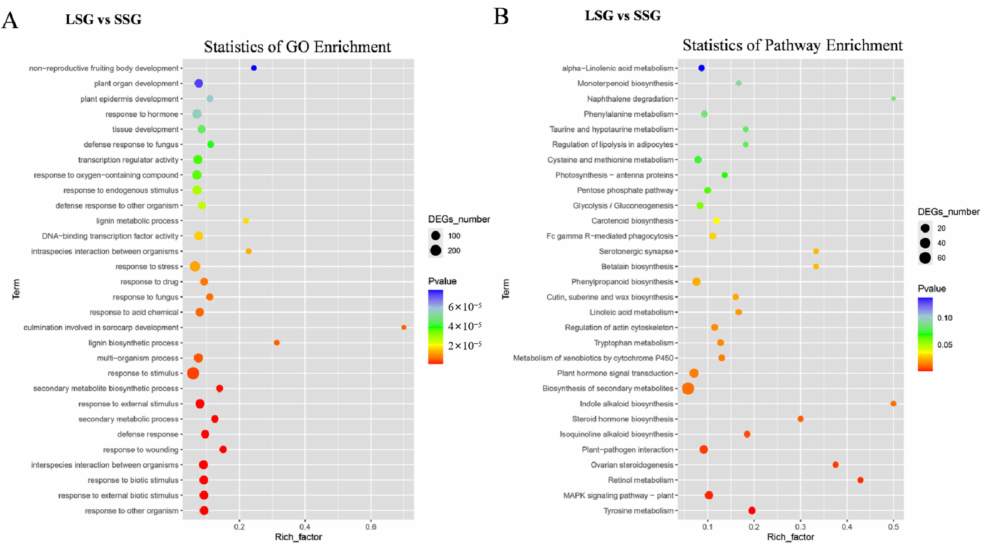
Figure 4. GO and KEGG enrichment analysis of DEGs between LSG and SSG. ( A ) GO enrichment analysis of DEGs; ( B ) KEGG enrichment analysis of